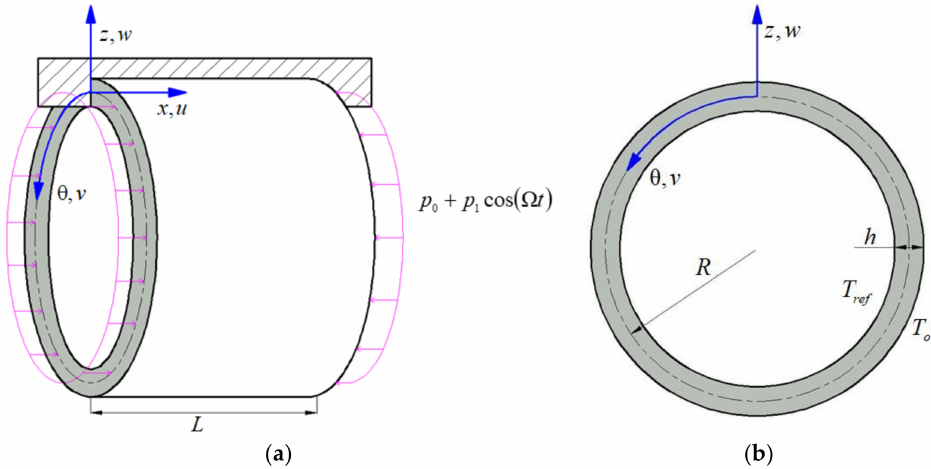
Figure 1. Model of a CFRP laminated cylindrical shell: ( a ) the mechanical model, ( b ) the sections of x = L and x =